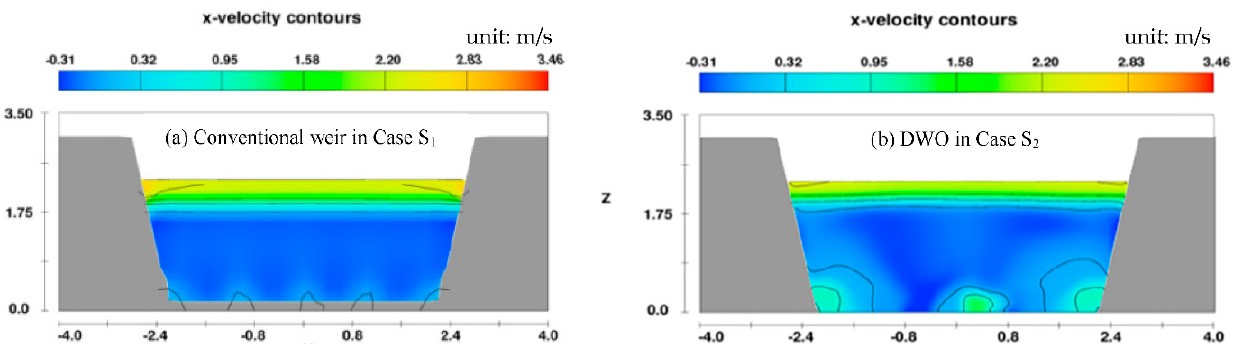
Figure 10. Water depth of Case S 1 obtained by two methods. The model experimental data and numerical simulation data both show an apparently fluctuating and discontinuous water surface line. They are in a good agreement due to similar resistance.